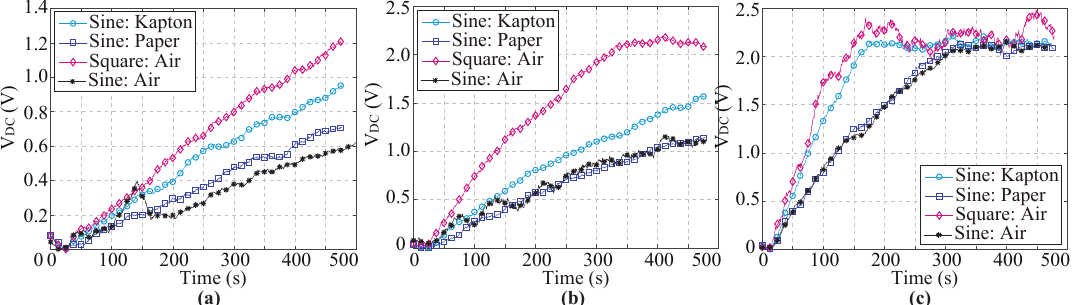
Figure 9. Comparison of EFEHs based on different dielectric materials, under the no load condition; ( a ) sheath length: 5 cm; ( a ) sheath length: 10 cm; ( a ) sheath length: 30